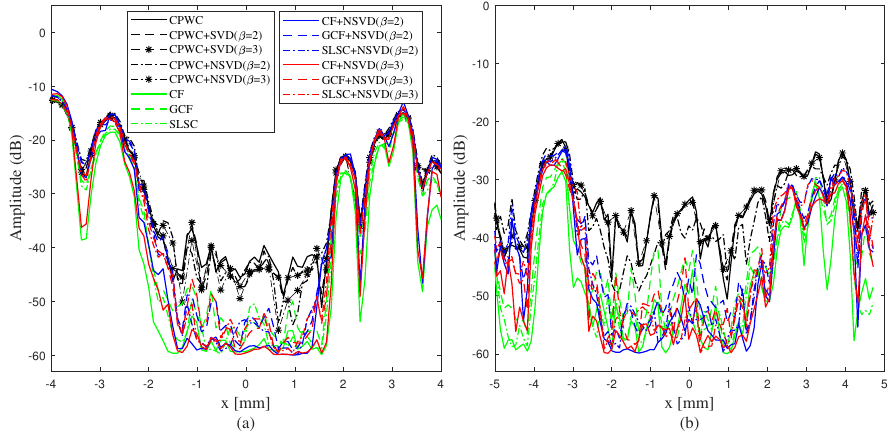
Figure 12. The lateral profiles of two experimental cysts centered at ( a ) ( x , z ) = ( 0 mm, 15 mm), ( b ) ( x , z ) = ( 0 mm, 43